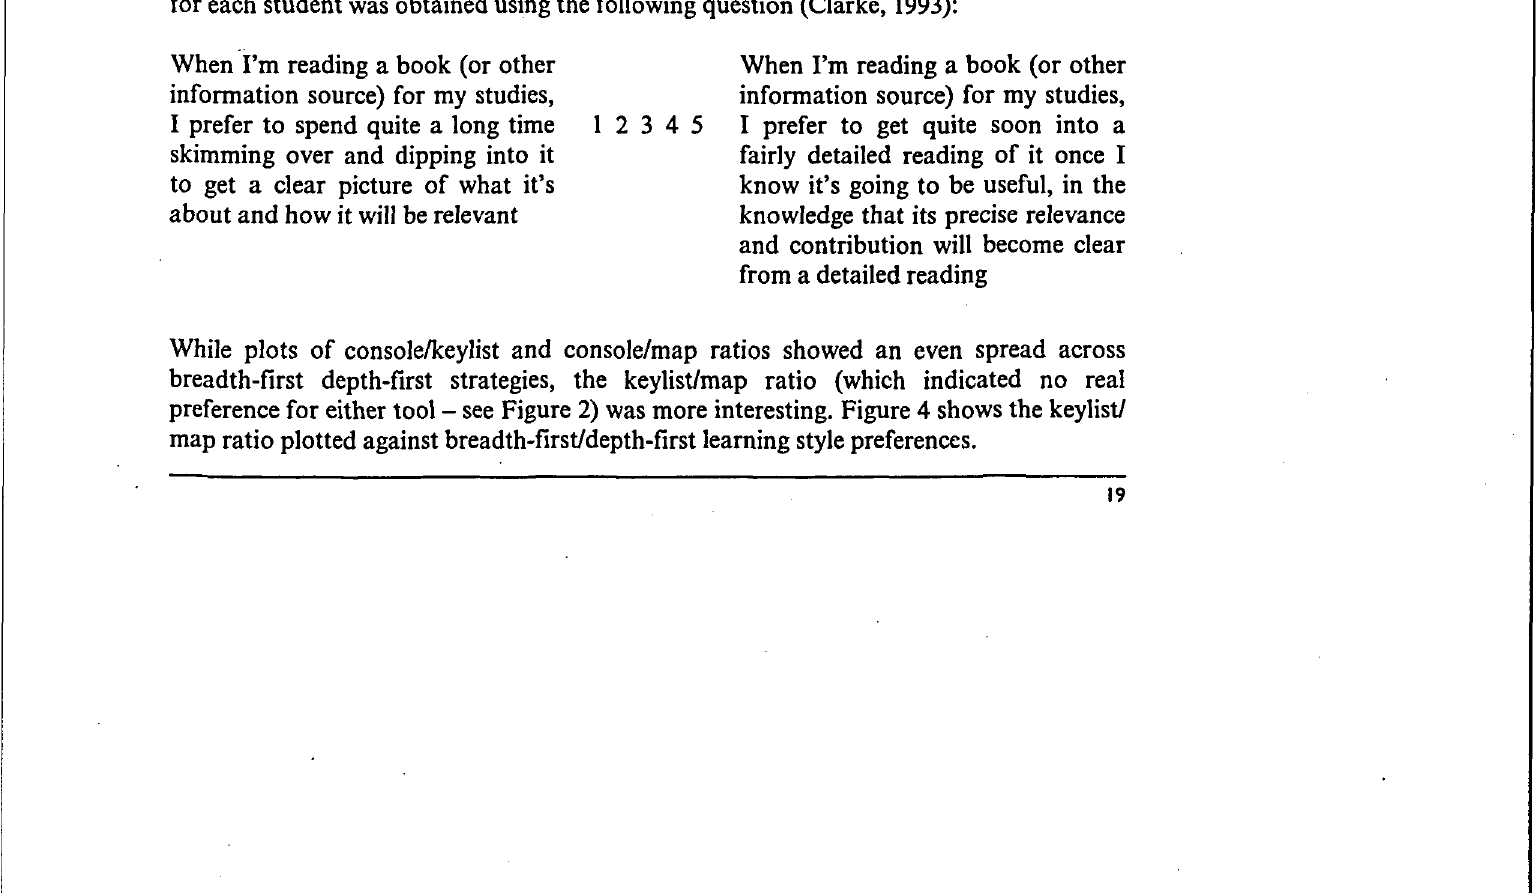
Figure 3: Scatterpbt of combined active-reflective learning style (Kolb) and number of pages